Question: What form of chart is displayed?
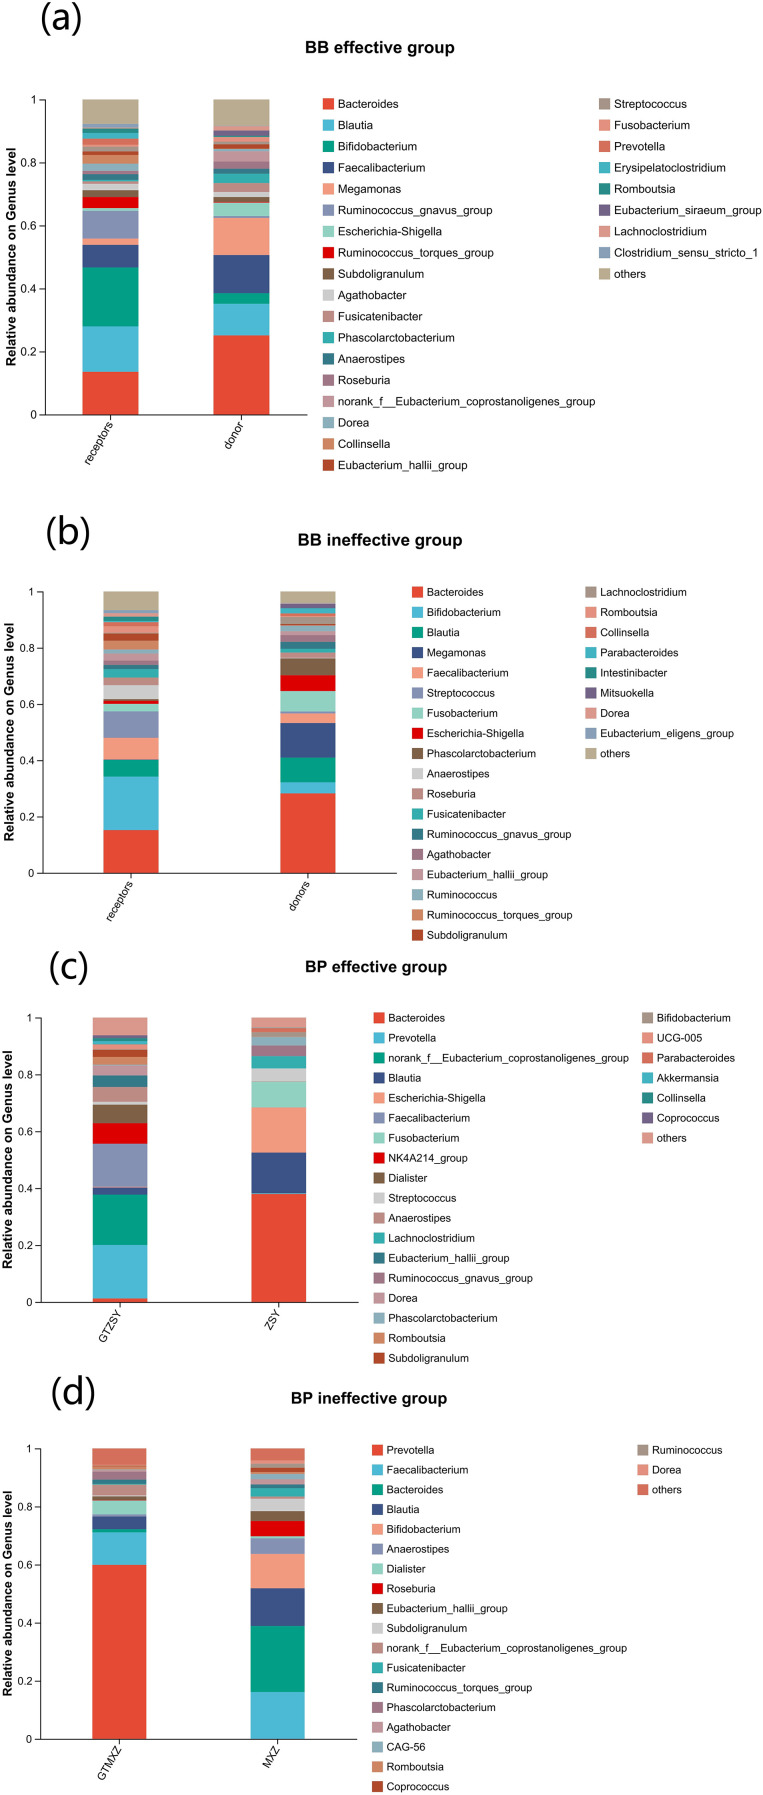
Answer: bar